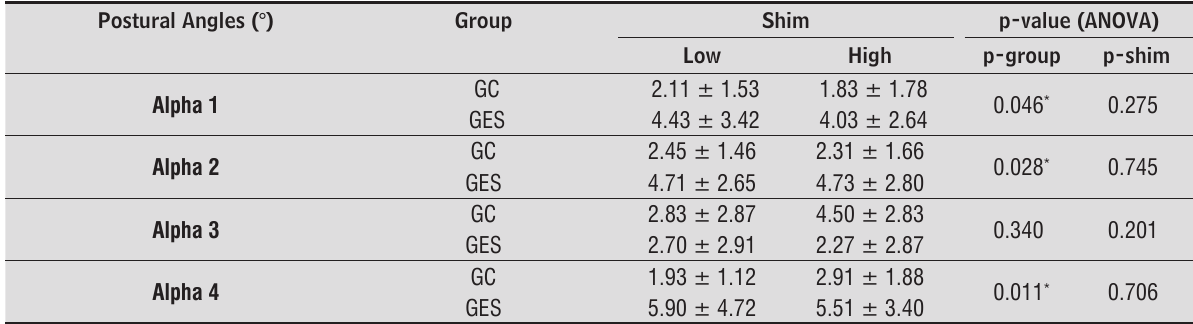
Table 3 - Analyses of postural angles with respect to the group and shim factors between the control and experimental "C" groups in the static condition with right